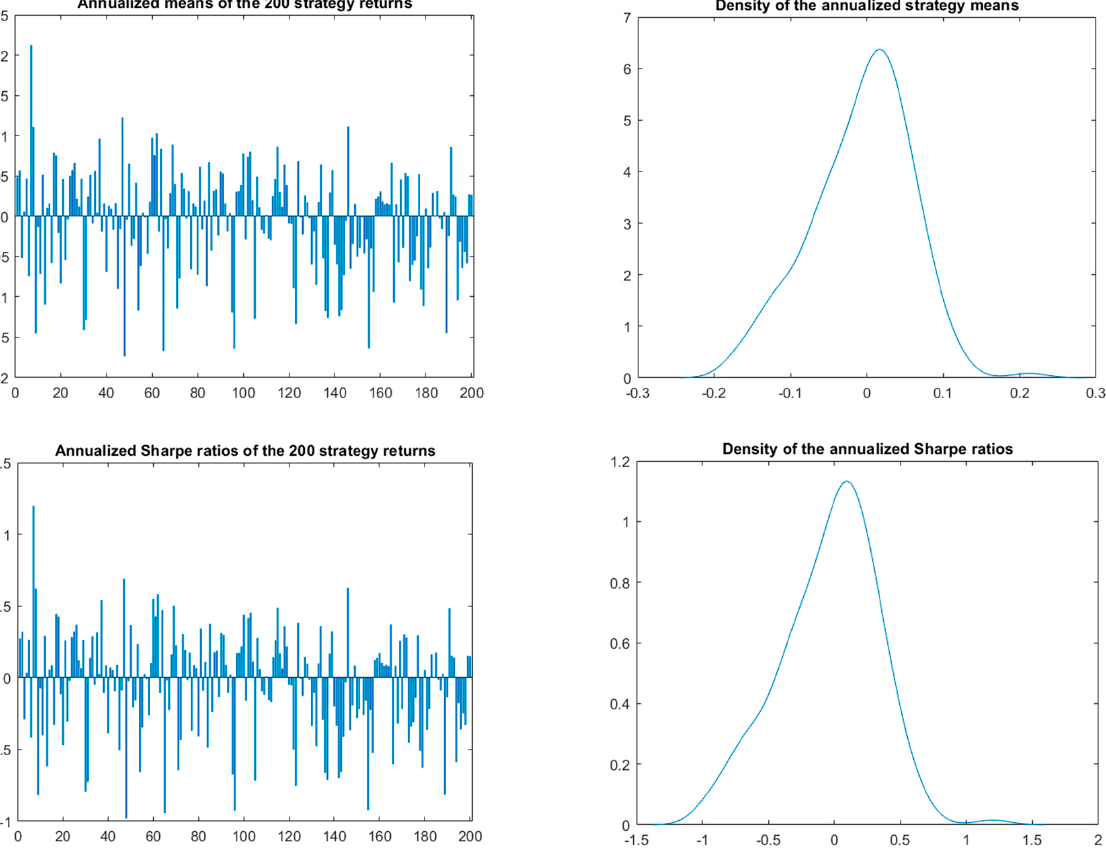
Figure 5. Annualized means of the selected 200 strategies and the Sharpe ratios’ probability distributions.